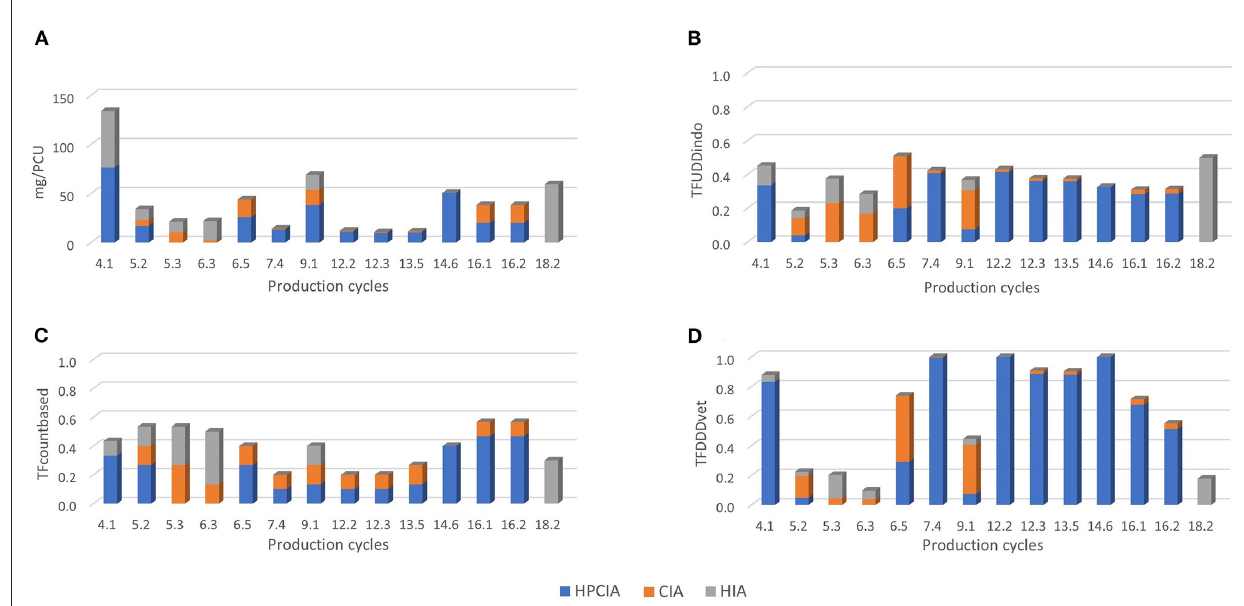
FIGURE3 Distribution of AMU amongst the different priority antimicrobial classes as defined by WHO (HPCIA, CIA and HIA) of the 14 production cycles that were ranked as “high AMU” within only one indicator. Individual production cycles are labeled as [farm.cycle]; 4.1 means cycle 1 on farm 4. (A) Distribution of AMU defined as mg/PCU. (B) Distribution of AMU defined as TF UDDindo . (C) Distribution of AMU defined as TF count − based . (D) Distribution of AMU defined as TF DDDvet .